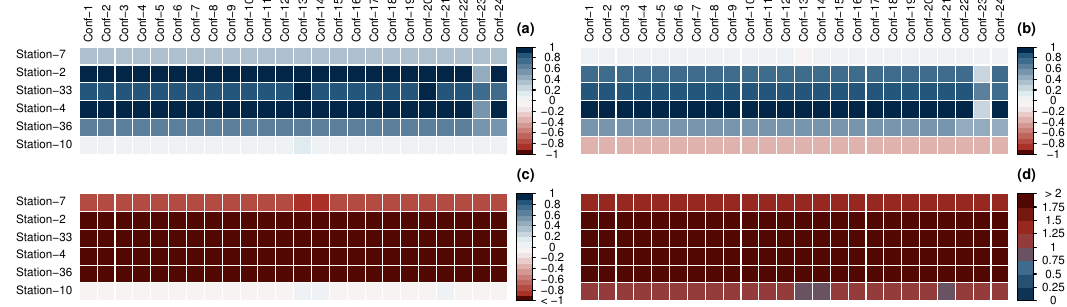
Figure A3. Matrix of statistics for surface pressure: ( a ) correlation, ( b ) KGE, ( c ) NSE, ( d )